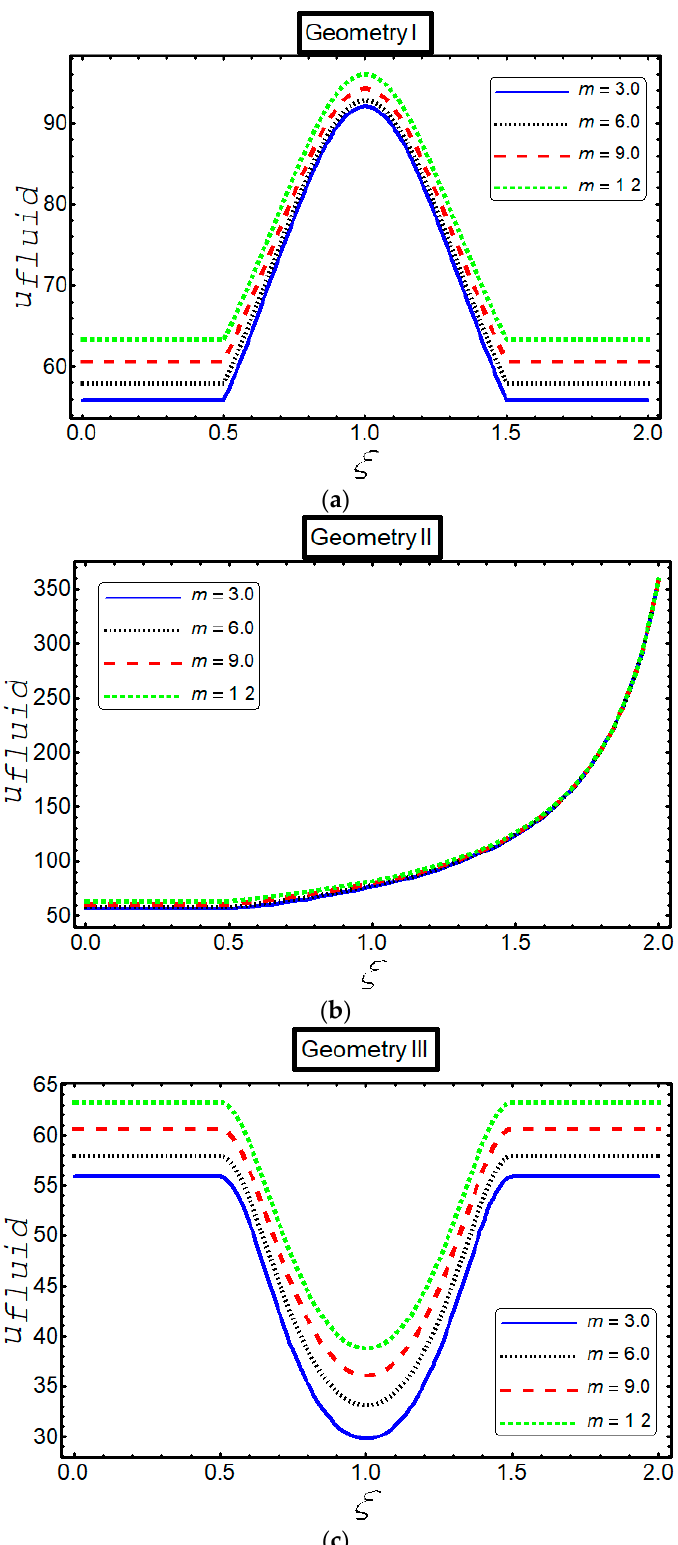
Figure 6. Velocity variation for electro-osmotic parameter.